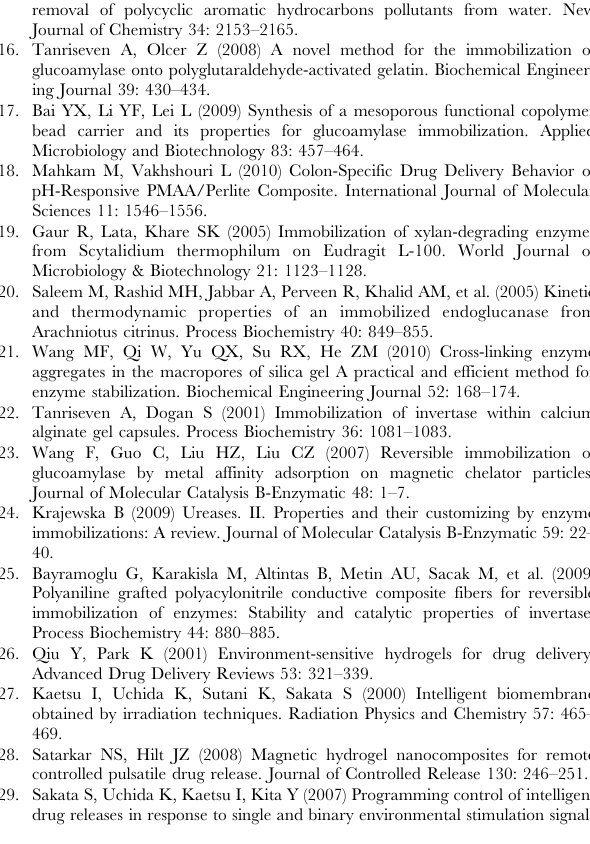
Figure S1 SEM image of the gluocoseamylase immobi- lized CLGNs prepared by adsorption method. (TIF)